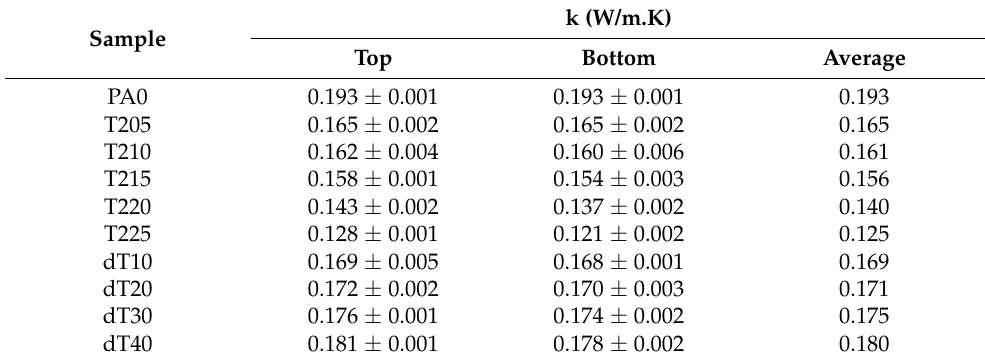
Table 4. Thermal conductivity of the unfoamed, uniform and graded POE foams. k (W/m.K) Sample Top